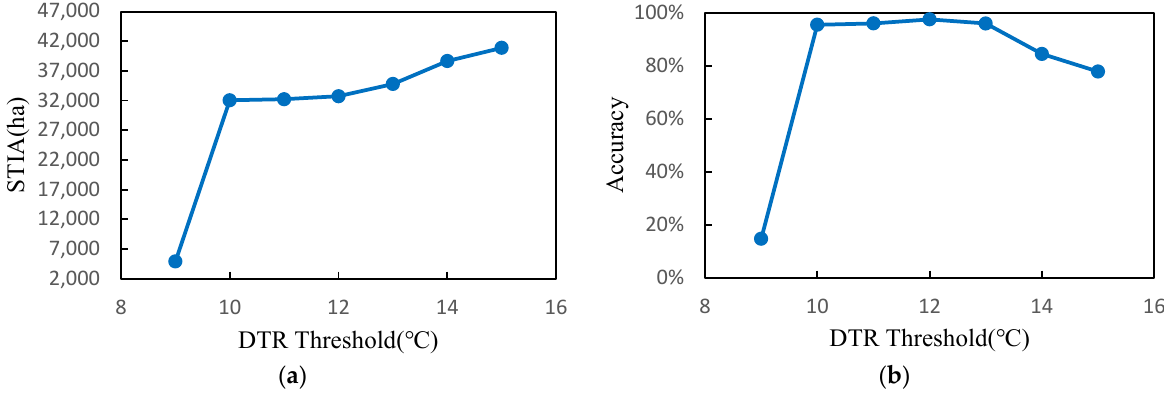
Figure 8. Sensitivity analysis of the DTR Threshold. ( a ) threshold sensitivity, ( b ) threshold accu- racy.